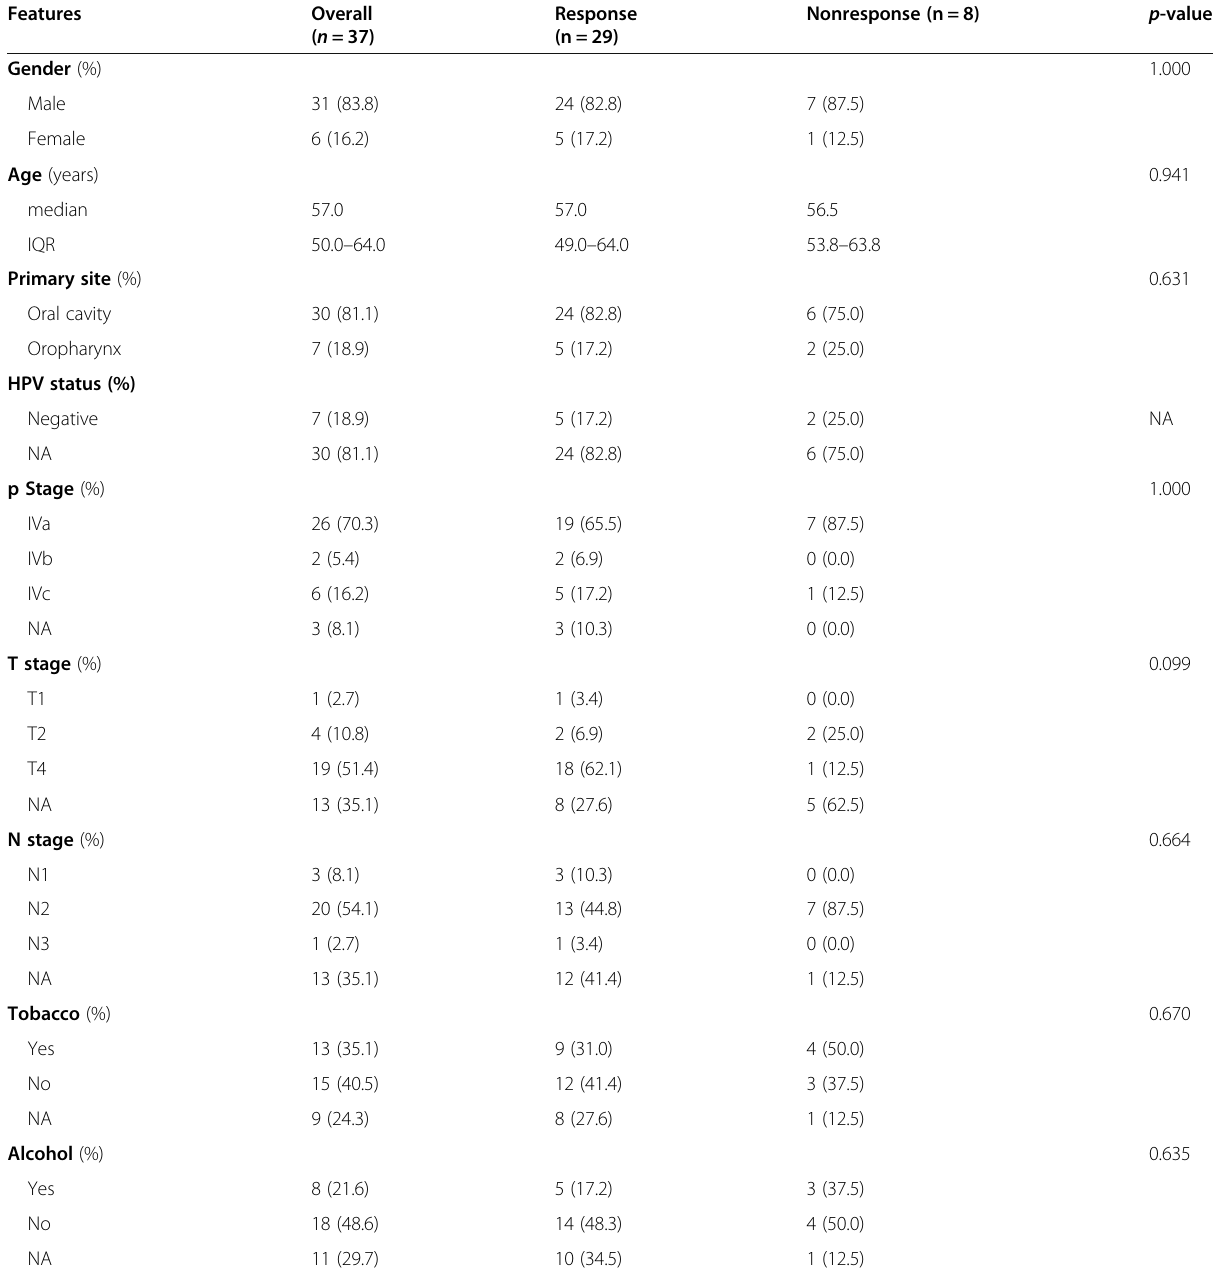
Table 1 The clinical features between response and nonresponse groups in the HNSC patients